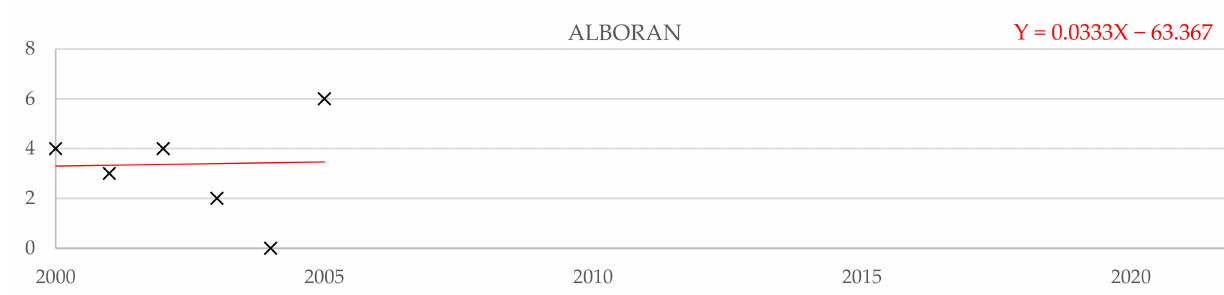
Figure 19. Number of times Hs has exceeded the threshold in the Gulf of Cadiz.